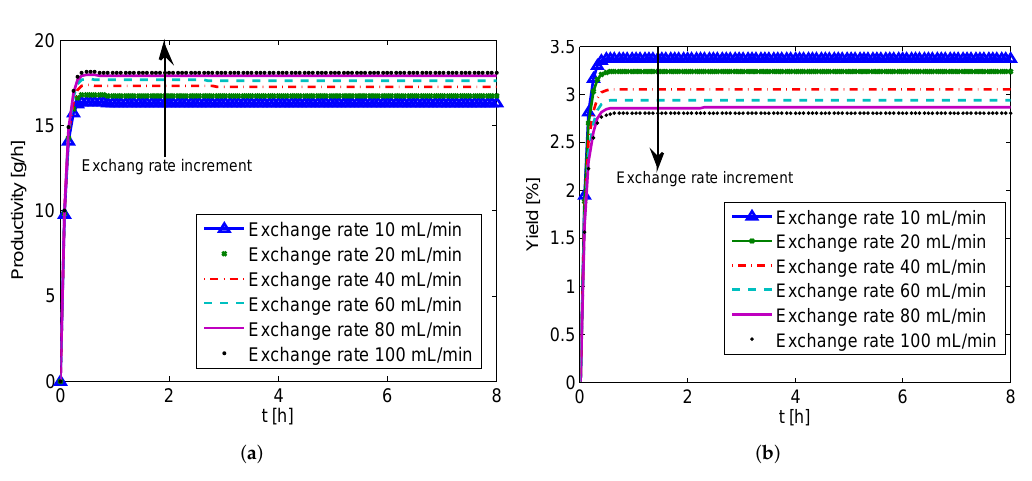
Figure 6. Simulation results showing the effect of the liquid phase exchange rate on the productivity and yield of the coupled preferential crystallization in MSMPR crystallizers (CPC-MSMPR) (feed flow rate 80 mL min − 1 , seed mass 2 g). ( a ) Increase of liquid phase exchange increases productivity; ( b ) Yield of the processes decreases while the feed flow rate increases, as an increase of the feed flow rate reduces the residence time of the solution.